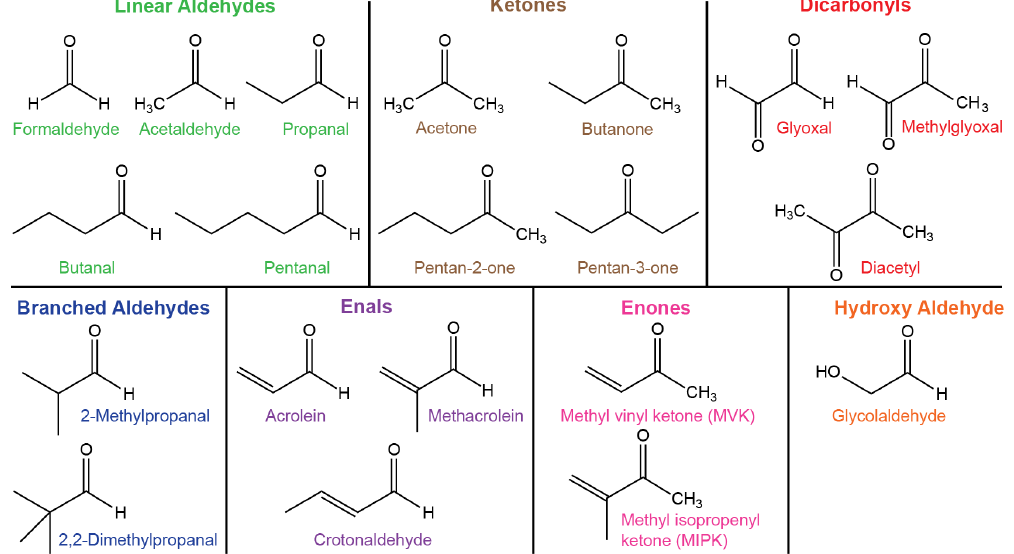
Figure 3. The 20 carbonyls in the test set, colour-coded according to carbonyl